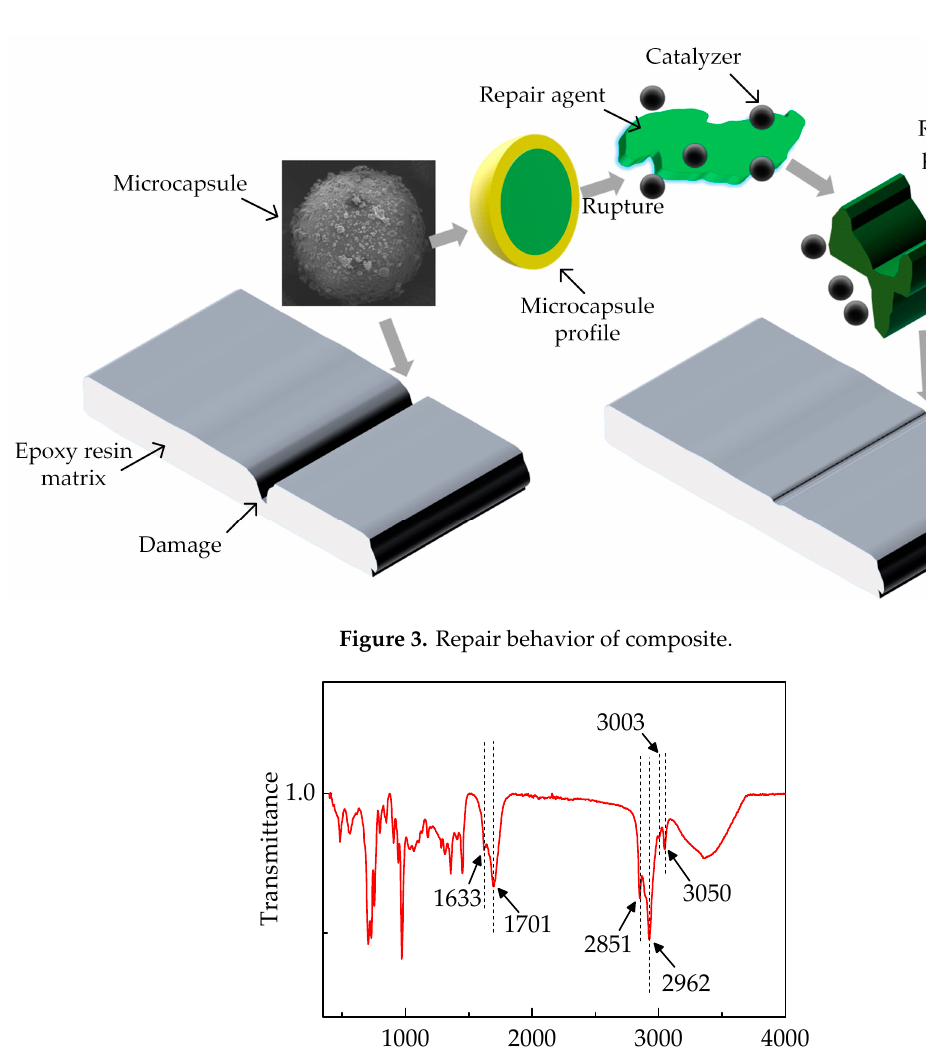
6 of 14 Figure 2. Morphology of the scratch: ( a ) Unheated pure LDPE epoxy resin; ( b ) Heated pure epoxy resin for 30 min; ( c ) Heated pure epoxy resin for 60 min; ( d ) Unheated composite without catalyst; ( e ) Heated composite without catalyst for 30 min; ( f ) Heated composite without catalyst for 60 min; ( g ) Unheated composite; ( h ) Heated composite for 30 min; and ( i ) Heated composite for 60 min. The scratch can destroy the microcapsules in the sample, resulting in the rupture of wall structure. And the heating condition would cause the core material to flow out. For the composite without catalyst, the unreacted DCPD was volatilized by heating. So, the scratch of this composite had no repair effect, which is similar to the pure epoxy resin. When the composite contained catalyst,